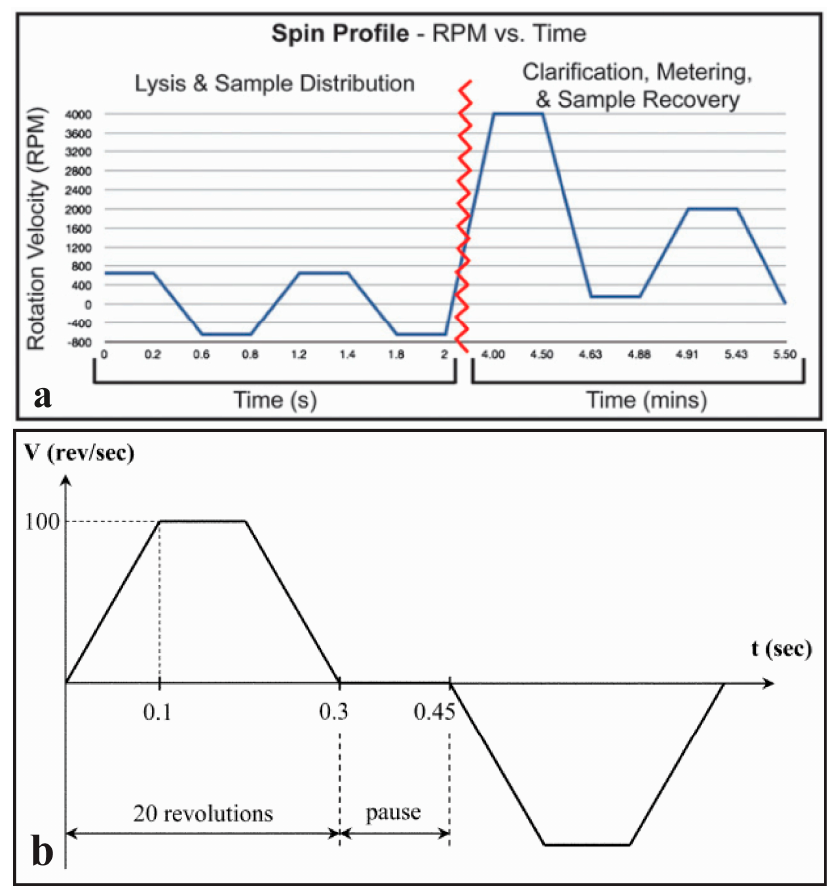
Figure 4. ( a ) Spin profile detailing motor velocity during lysis, measuring and recovering of the sample. Reprinted with permission of the Royal Society of Chemistry [34]; ( b ) Spin profile of cell lysis using rapid spinning in opposite directions to induce particle collisions. Reprinted with the permission of the Royal Society of Chemistry [55].